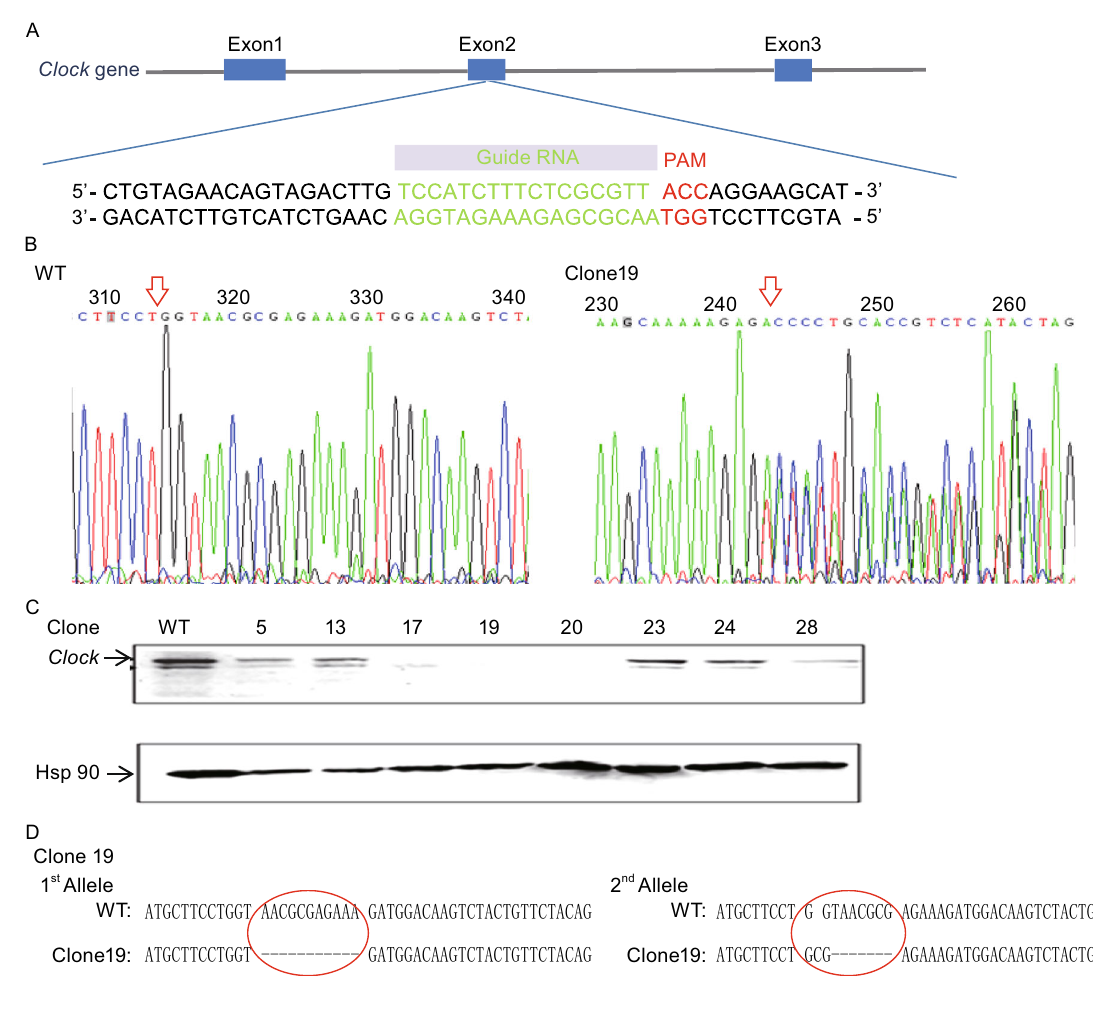
Figure 1. Generation of Clock knockout mESC line using CRISPR/CAS9 gene editing. (A) Schematic diagram of the 5 ′ end of the Clock gene (blue bars, exons), the CRISPR/CAS9 gRNA sequence (red bar, the green shaded part), PAM domain (the red shaded part). (B) Representative sequencing showing modi fi cations at the CRISPR/CAS9 cutting site on exon 2 of the mouse Clock gene. (C) Western blot revealed CLOCK expression in the positive clones following editing by the CRISPR/CAS9 system. (D) TA cloning results involving a representative homozygous clone (clone 19) show that both alleles of the mouse Clock gene were modi fi ed on exon 2 by the CRISPR/Cas9